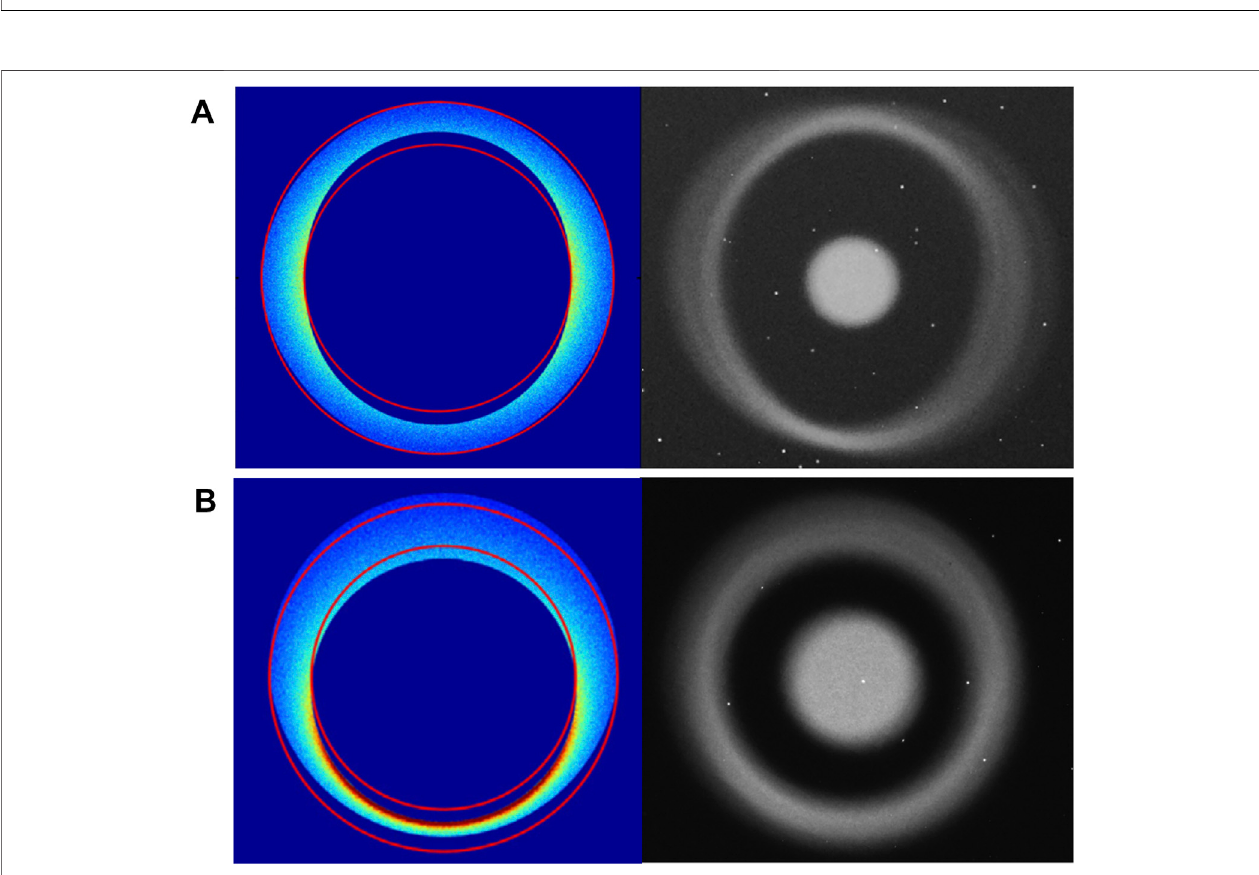
Frontiers in Physics |